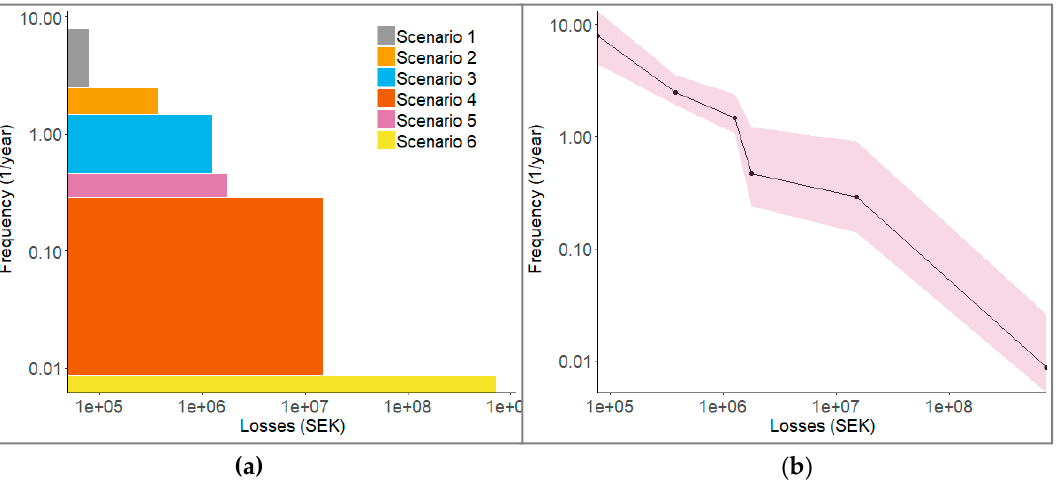
Figure 2. Estimated annual risk of the reference alternative for analyzed scenarios in the form of staircase ( a ), and in the form of a risk curve showing the mean values and frequency percentiles P05 and P95 ( b ). Note that the curves are plotted on log-log scales with cumulative frequencies.